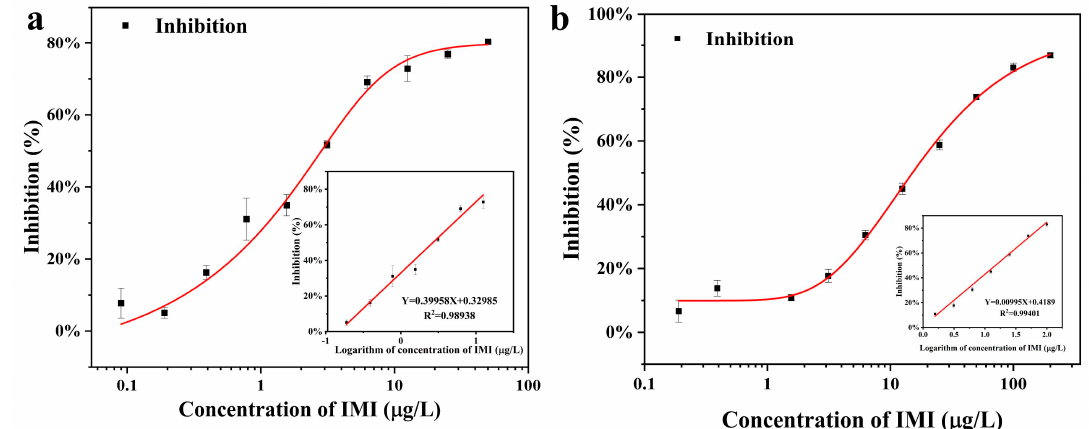
Figure 5. ( a ) Standard curve for the detection of IMI using Cl-ELISA. ( b ) Standard curve for the detection of IMI using Co-ELISA.